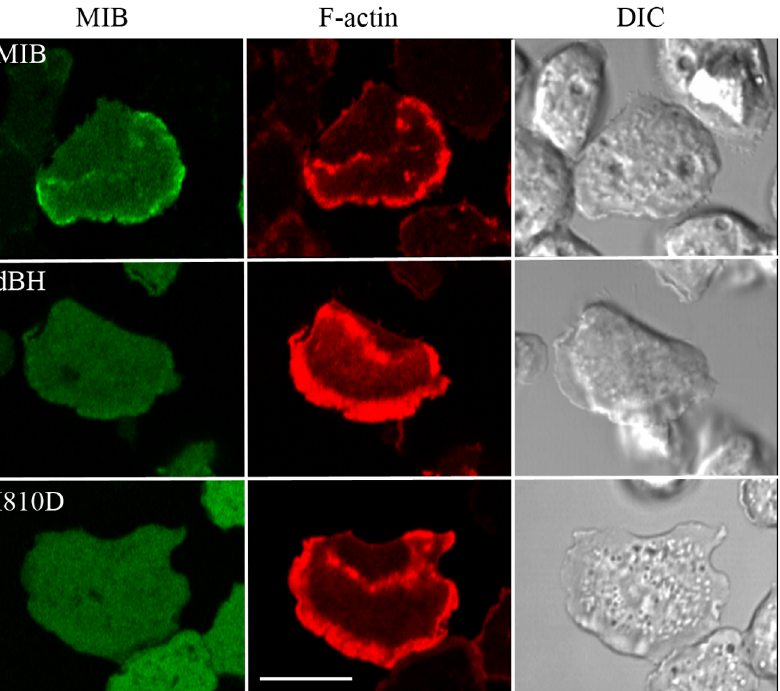
Figure 7. The BH-site is essential for the association of MIB with actin waves. myoB 2 -cells were co-transfected with mRFP-lifeact and either GFP-MIB, GFP-dBH or GFP-I810D as indicated in the figure. Neither GFP-dBH nor GFP-I810D binds acidic phospholipids. Cells were starved for 30 min after which 1 m M latrunculin was added and cell images were recorded. MIB associated with the actin wave but dBH and I810D did not. Bar is 10 m m.